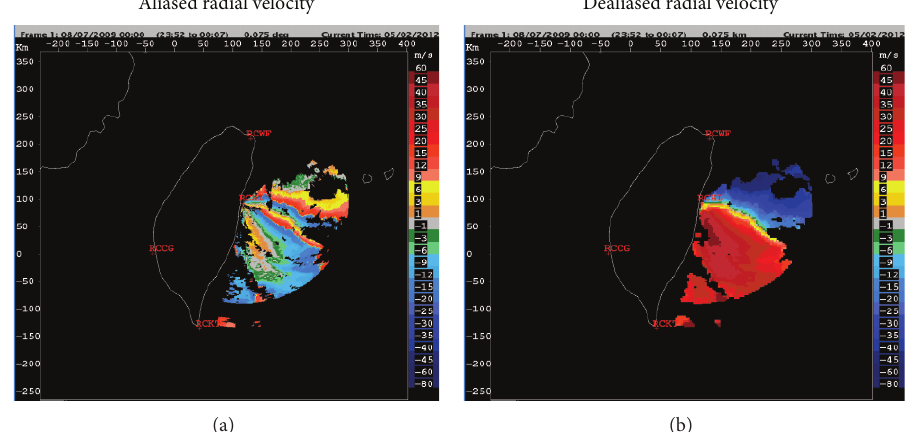
Figure 2: Radial velocity observations at 0.5 ∘ elevation from RCHL radar of the Central Weather Bureau (CWB) of Taiwan before (a) and after (b) the dealiasing scheme in VDRAS was applied. The thin white contours are costal